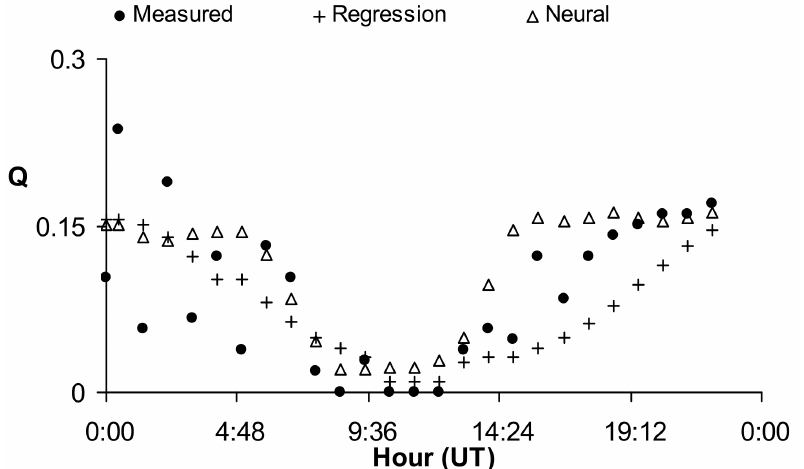
Figure 10. Allocation 16 at a threshold of 30 dB µ V/m.